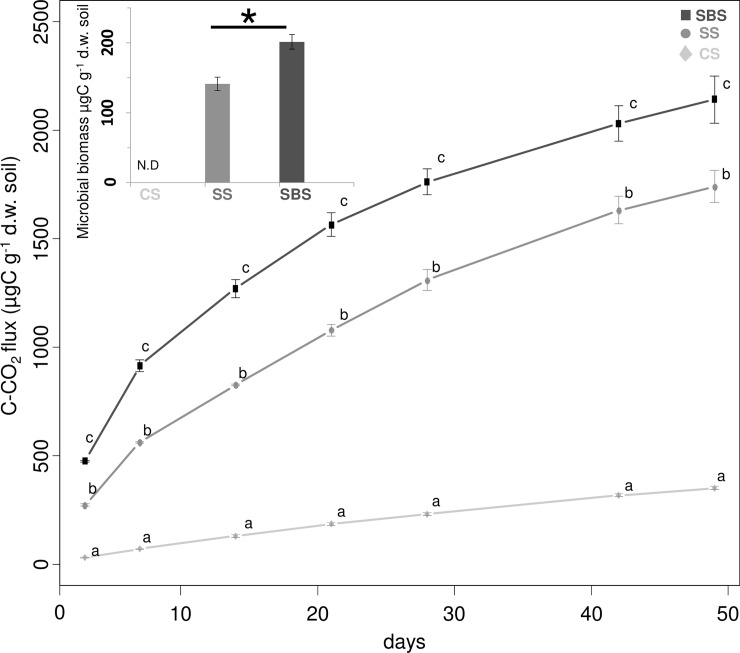
Cumulative kinetics of the orgC mineralization and microbial biomass carbon in, the control soil (CS), the soil with straw (SS) and the soil with straw and the BS (SBS).The error bars indicate the standard errors of the C-CO2 emission mean values (n = 3). At each sampling date, the data indicated with different letters are significantly different according to the Kruskal-Wallis test. The microbial biomass carbon in the control soil was not determined (ND). The C-CO2 emission and microbial biomass are “expressed” per g of dry soil (d.w.). The (*) correspond to significantly different values of microbial biomass carbon.